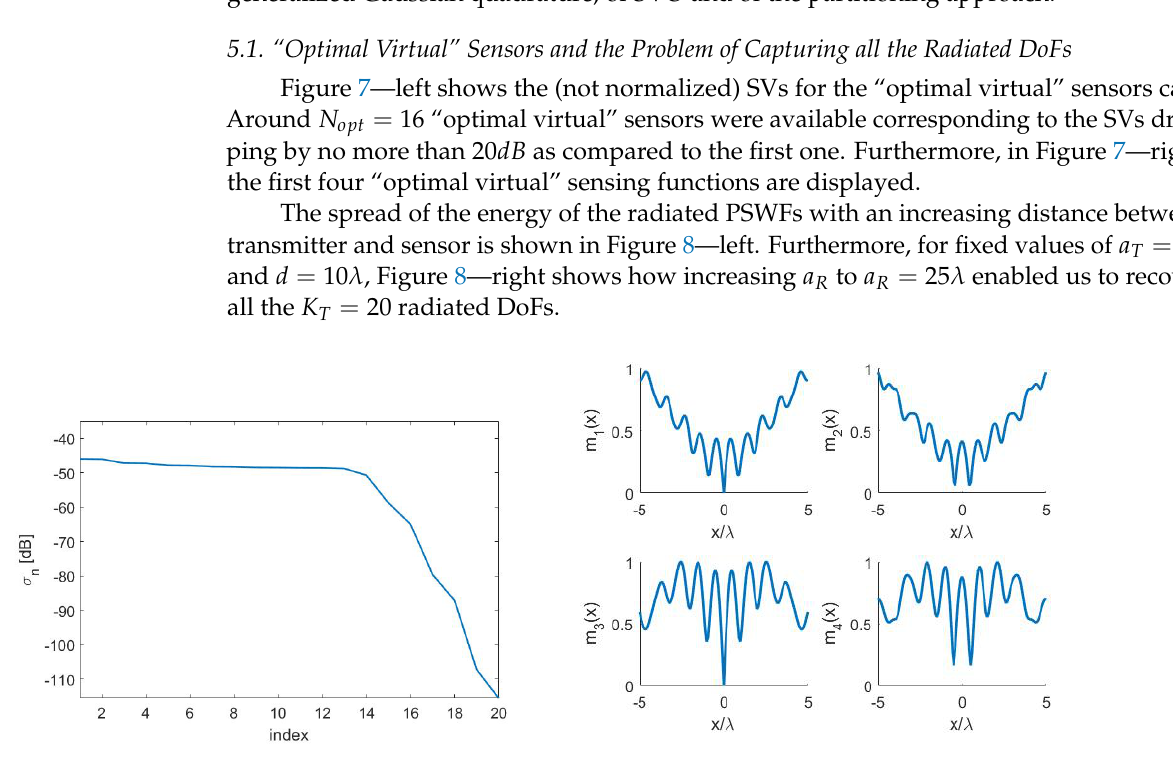
Figure 7. ( Left ): SVs for the case a T = 5 λ , a R = 7 λ and d = 7 λ . ( Right ): first four “optimal virtual” sensors for the case a T = 5 λ , a R = 7 λ and d = 7 λ .